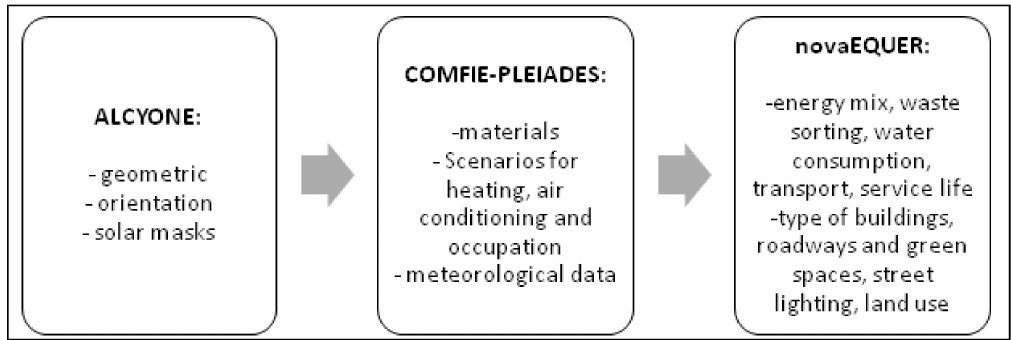
Figure 2. The study area location.